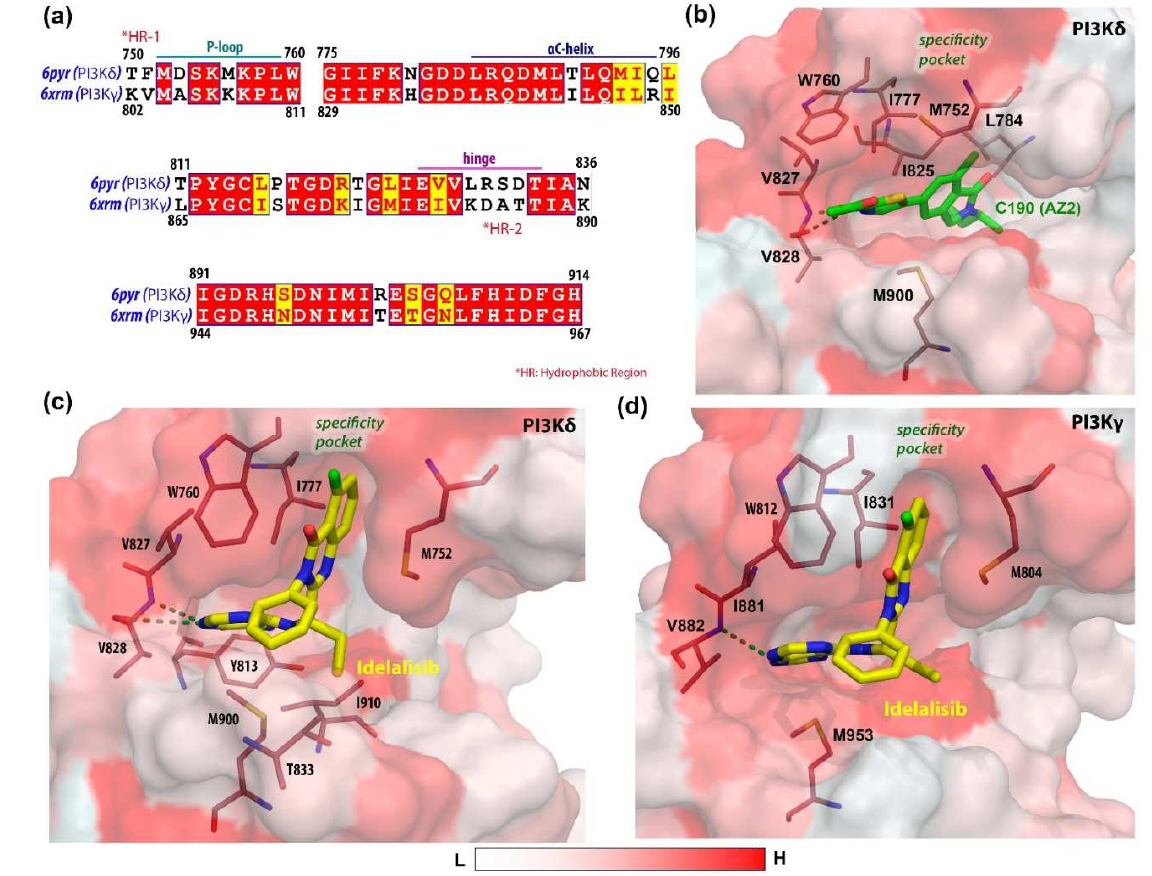
Figure 4. Sequence alignment of the active sites and ligand interactions inside the hydrophobic cavity of δ and γ isoforms of PI3K. ( a ) Consensus sequence alignment of the active sites of two isoforms. The conserved amino acid residues are highlighted in warm red. ( b ) The final 1 ns average MD structure of C170 (AZ2)-bound PI3Kδ. The final 1 ns average MD structures of the idelalisib-bound active sites of PI3K and PI3K, respectively, are shown in ( c ) and ( d ). The H-bond interactions are shown in dotted green lines. The white to red surface indicates ascending hydrophobicity.